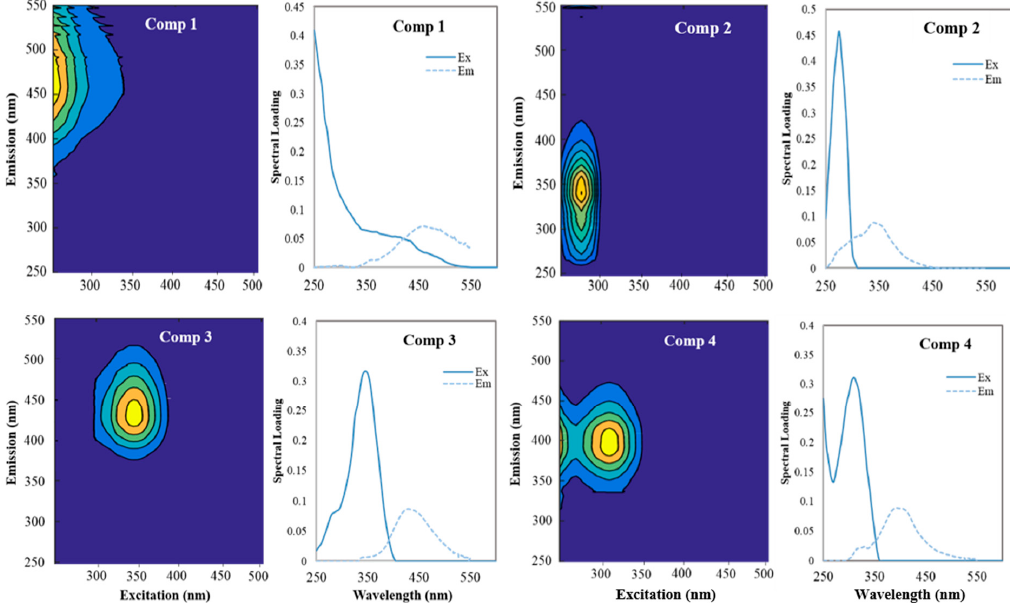
Figure 1. Contour plots of the four components derived from the excitation-emission matrices (EEM) dataset after PARAFAC analysis ( Left ), and line plots showing spectral loadings on four components ( Right ). The relative abundances of five regions identified based on the method of Chen, et al. [12] are summarised in Figure 2. The results showed higher percentages of protein compounds (P1, P2 and SMP) as compared to organic compounds (HA and FA), and these findings are comparable to others that supported a higher proportion of proteins in wastewater